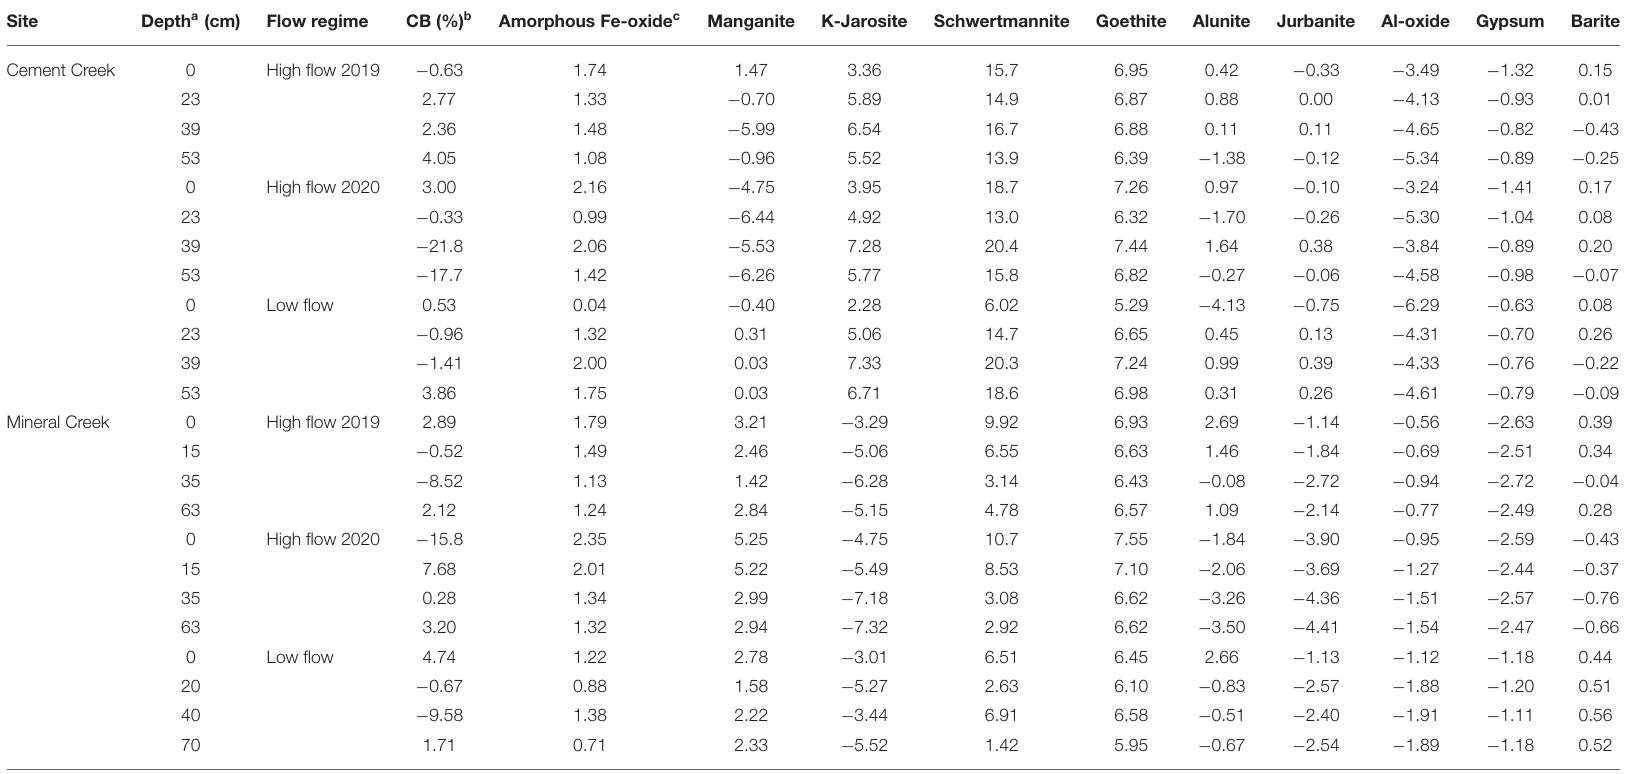
TABLE 5 | Saturation indices calculated in PHREEQ-C using stream and hyporheic zone water chemistry. Site Depth a (cm) Cement Creek